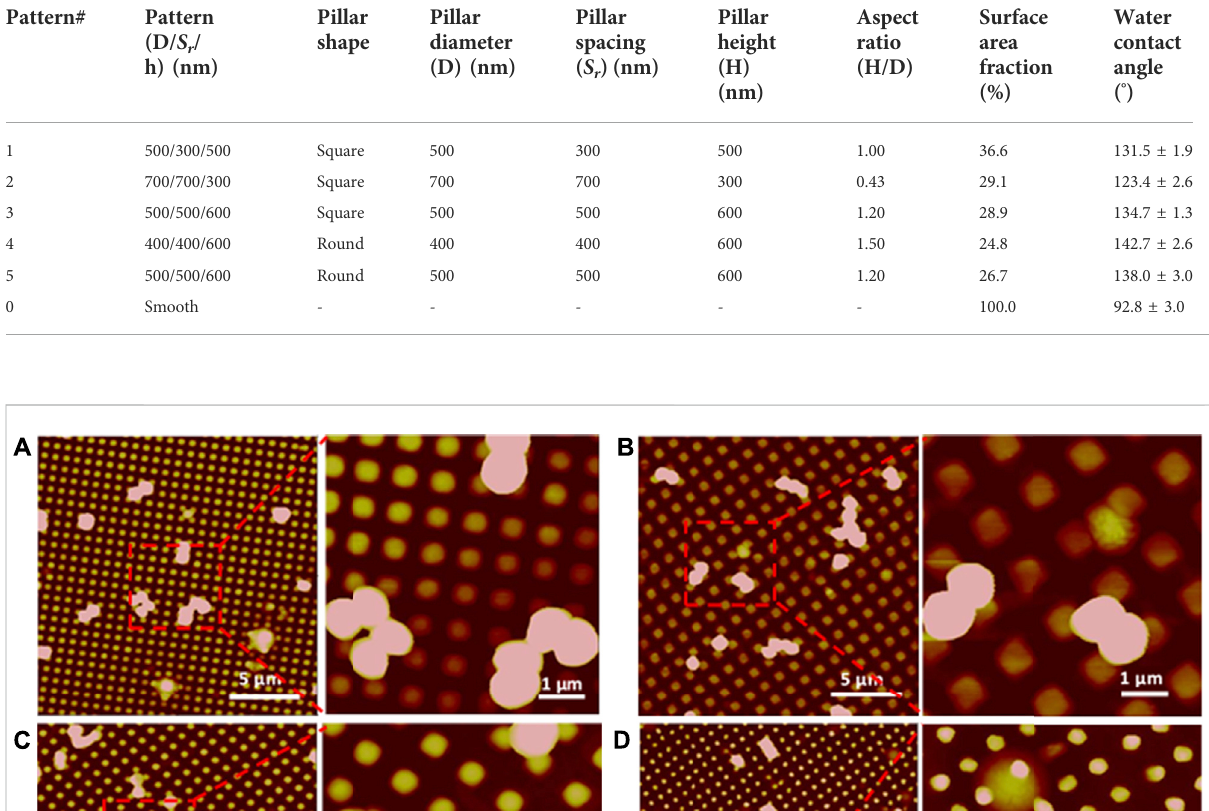
TABLE 1 Design parameters of textured pillars and the properties of textured surfaces on PUU substrate [65].